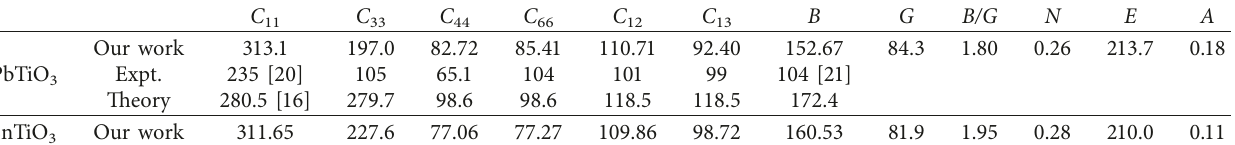
Table 2: Computed elastic properties of SnTiO 3 and PbTiO 3 as compared to the available theoretical